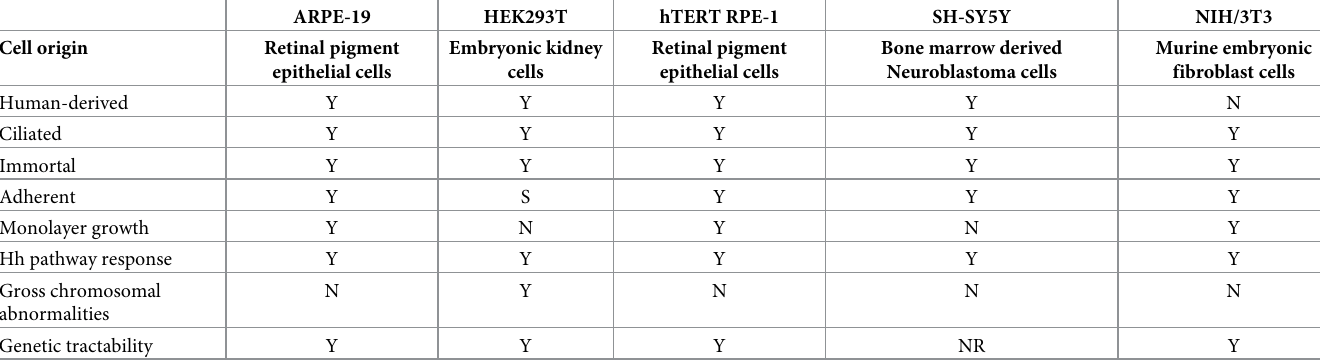
Table 2. Desired cell line characteristics for modeling Hh